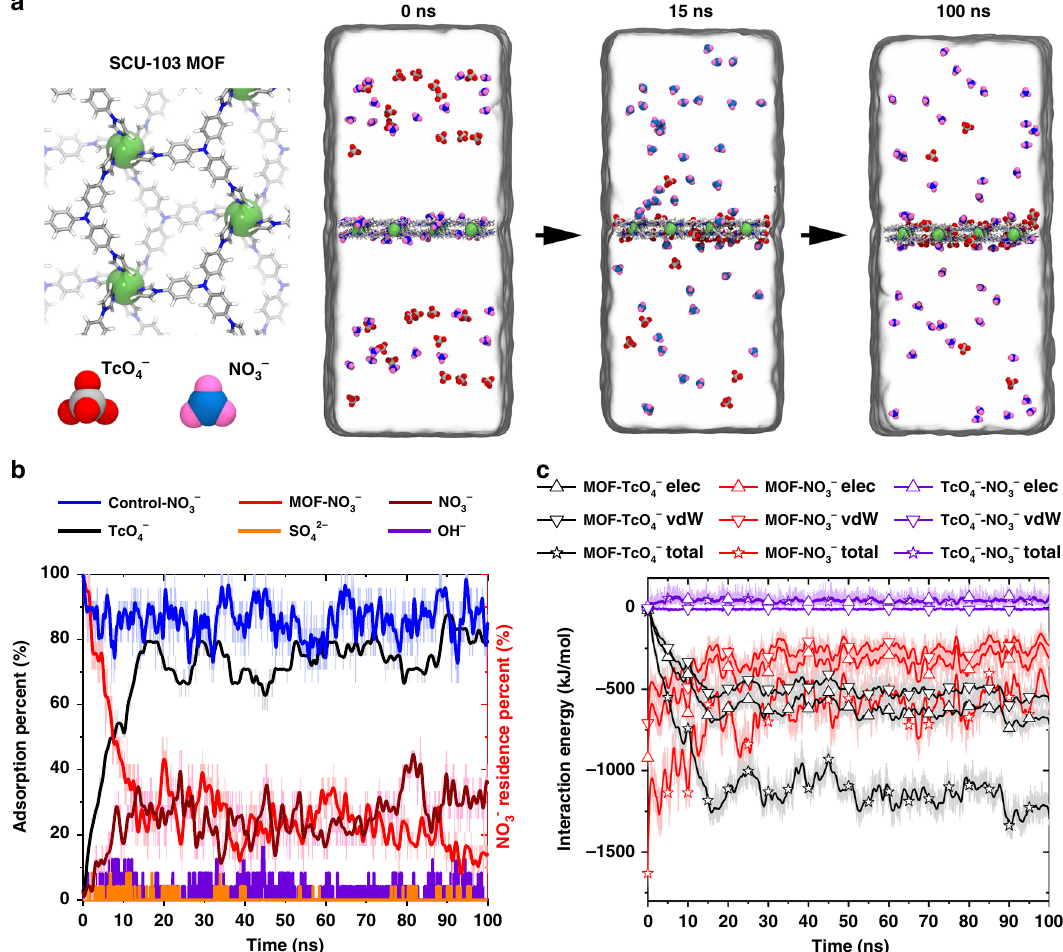
Fig. 5 All-atom molecular dynamics simulations for the selective sorption of 99 TcO 4 − into SCU-103 against various competing anions (including NO 3 − , SO 4 2 − , and OH − ). a Local structure of SCU-103, TcO 4 − , and NO 3 − (left panel). Some snapshots at critical time points to show the anion- exchanging process of TcO 4 − over NO 3 − anions (right panel). b Adsorption ratios of TcO 4 − (black), NO 3 − (red), SO 4 2 − (orange), and OH − (purple) that originally diffused in bulk water, and the residence ratio of NO 3 − originally located in SCU-103 without any competing anions (navy blue curve). c Time evolution of the non-bonded interaction energies (including electrostatic part, van der Waals part and their sum) of MOF-TcO 4 − , MOF-NO 3 − , and TcO 4 − - NO 3 − energetically favorable binding sites in SCU-103 are − 17.9 kJ/mol and − 10.0 kJ/mol, respectively. At the crucial intermediate state, the binding of 99 TcO 4 − can signi fi cantly diminish the global binding free energy minimum of NO 3 − at the distance of 0.21 nm, and meanwhile, the binding free energy of NO 3 − at the position is remarkably increased by a ΔΔ G = 9.5 kJ/mol, which eventually reaches − 0.5 kJ/mol (nearly comparable to the bulk value) (Fig. 6c, red curve). The data imply that the electrostatic repulsion introduced by 99 TcO 4 − can completely offset the binding af fi nity between NO 3 − and SCU-103, leading to the diffusion of NO 3 − from the interior of SCU-103 into the bulk water. At the transition state, the binding af fi nity of 99 TcO 4 − can also be weakened by NO 3 − , e.g., the binding free energy of − at the distance of 0.20 nm increases from − 17.9 kJ/mol 99 TcO 4 to − 13.8 kJ/mol (Fig. 6b, red curve). However, this value is still the global minimum throughout the full 99 TcO 4 − adsorption PMF curve (Fig. 6b, red curve), suggesting the moment when − is bound close to the imidazole ring within the cavity 99 TcO 4 still represents the most energetically favorable binding state during the whole process.